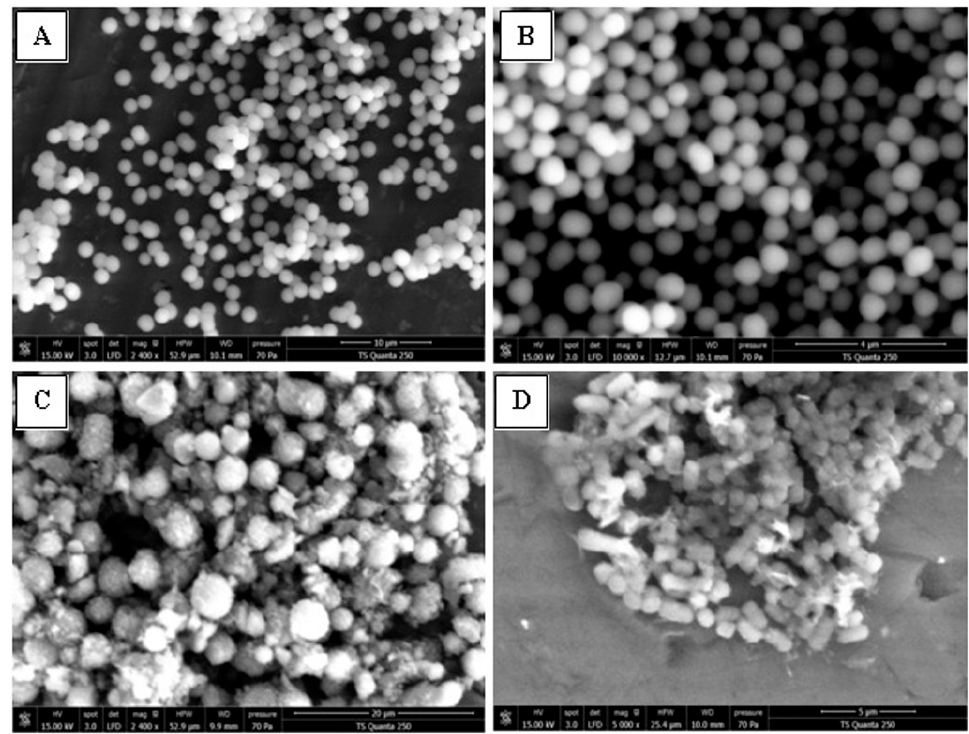
Figure 14. Scanning electron microscopy of untreated S. aureus ( A ) and S. aureus treated with 1 × MIC ( B ), 4 × MIC ( C ), and 10 × MIC ( D ) of flavonoids.